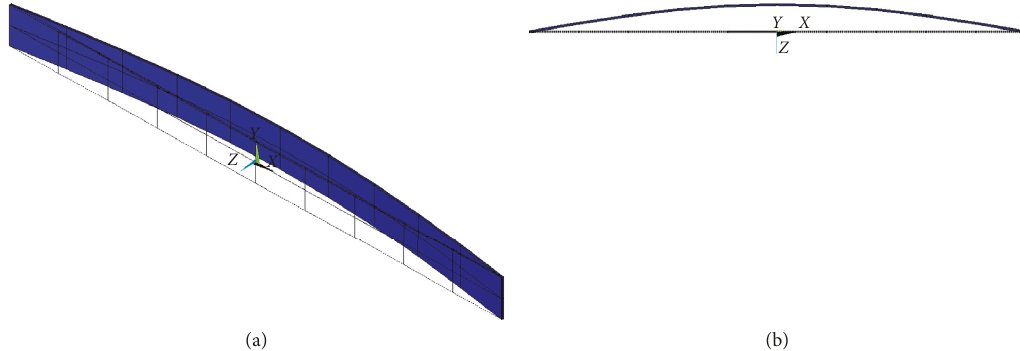
Figure 7: FEM model of a thin-walled beam with simply supported ends in ANSYS mechanical APDL: (a) 3D view and (b) top view.